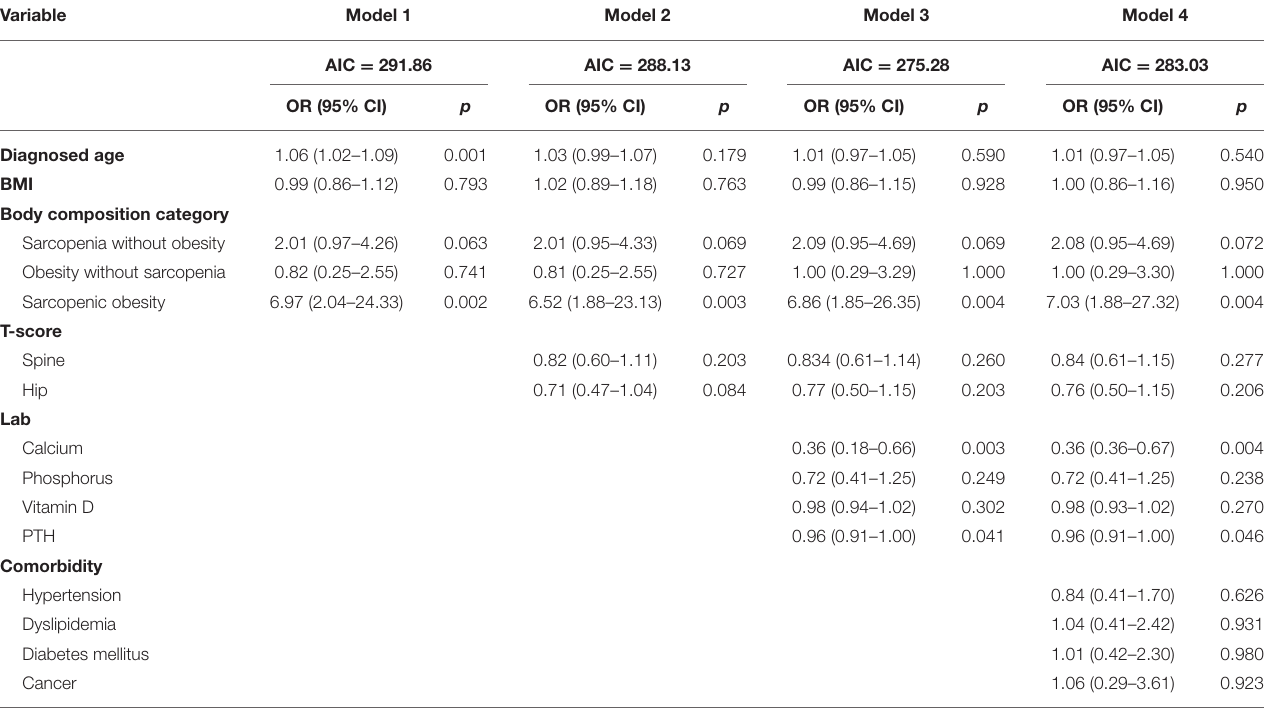
TABLE 5 | Multivariate logistic regression analysis of factors associated with acute VOCF for